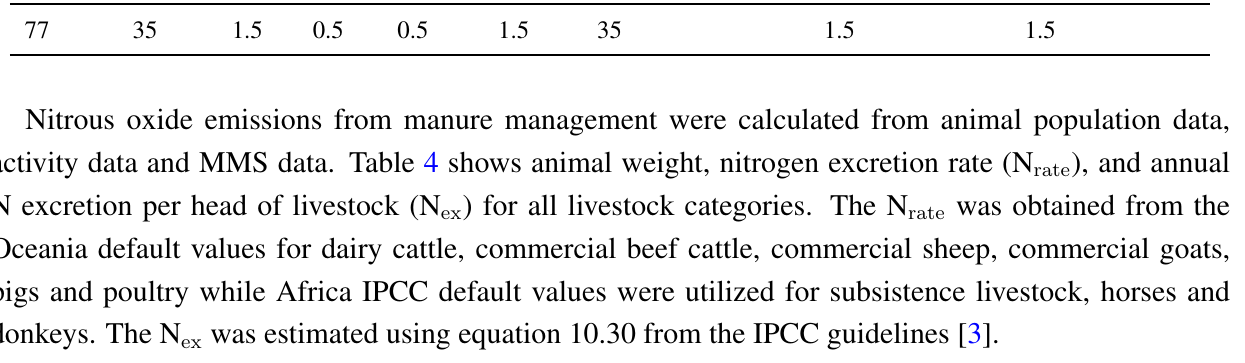
O emissions from 2